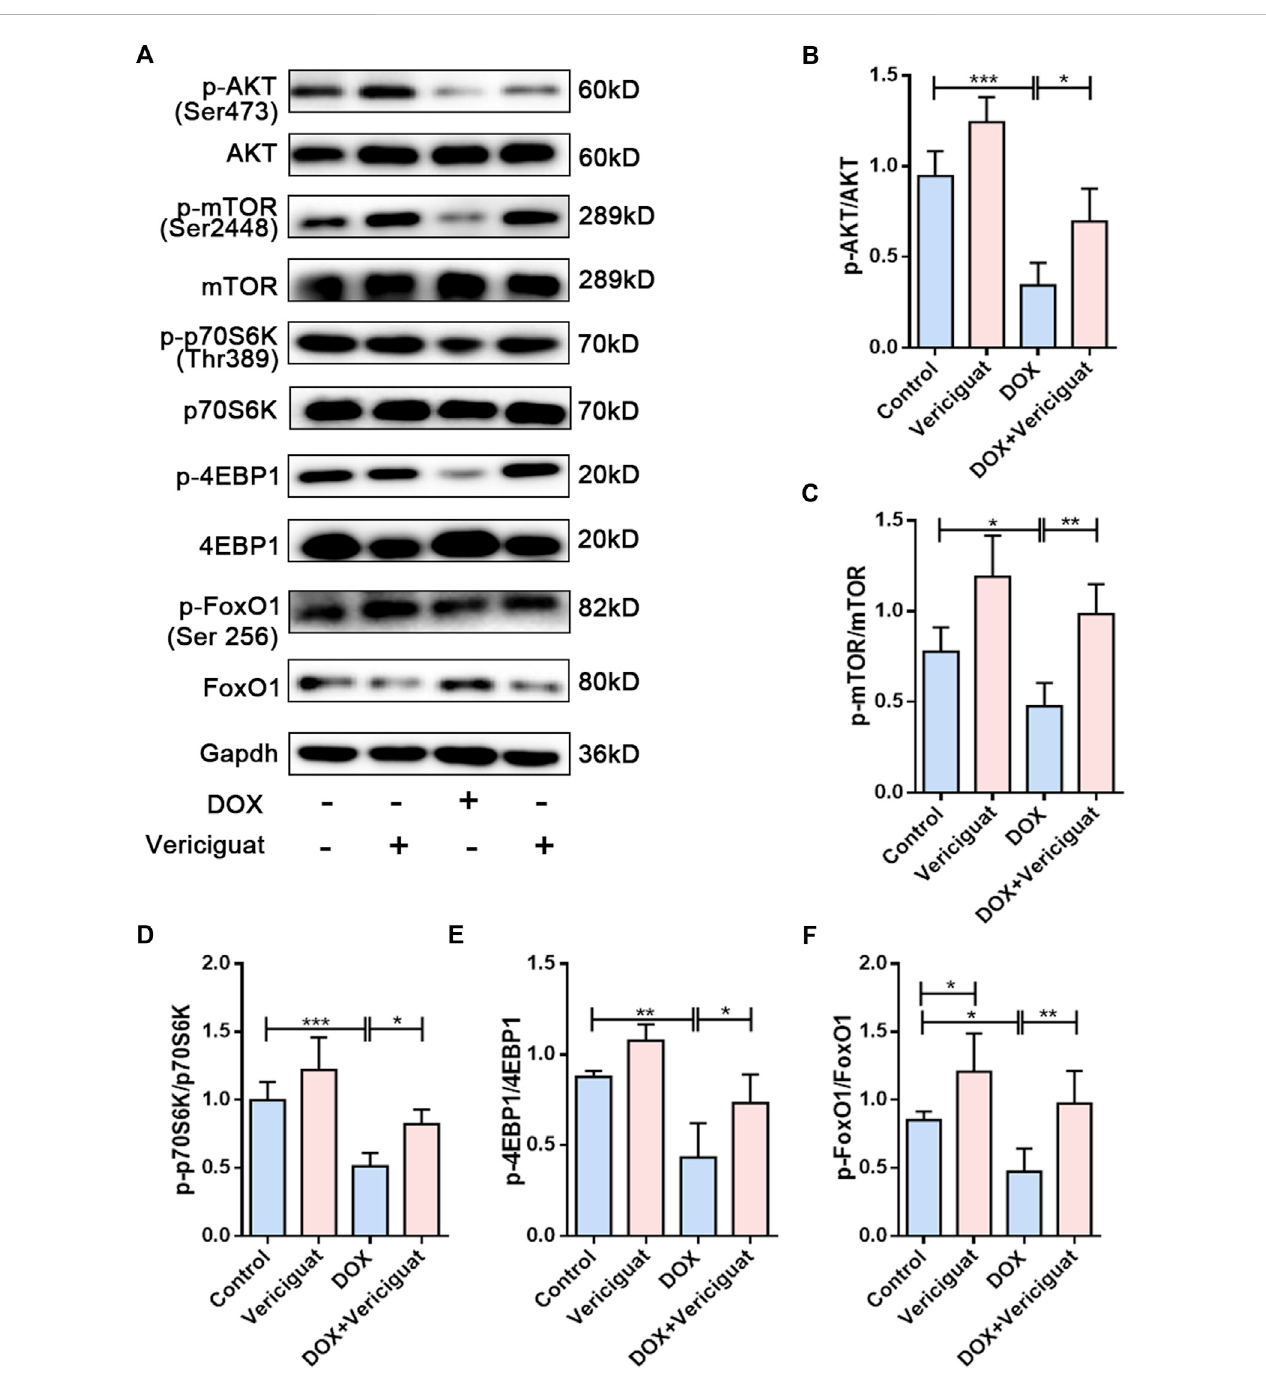
FIGURE 5 Vericiguat restored AKT/mTOR and FoxO1 pathways in DOX mice. (A) Expression of p-AKT, AKT, p-mTOR, mTOR, p-p70S6K, p70S6K, p-4EBP1, 4EBP1, p-FoxO1 and FoxO1 detected through western blot. (B – F) Relative protein expression levels of p-AKT, AKT, p-mTOR, mTOR, p-p70S6K, p70S6K, p-4EBP1, 4EBP1, p-FoxO1 and FoxO1. n = 5; *p < 0.05, **p < 0.01, ***p <